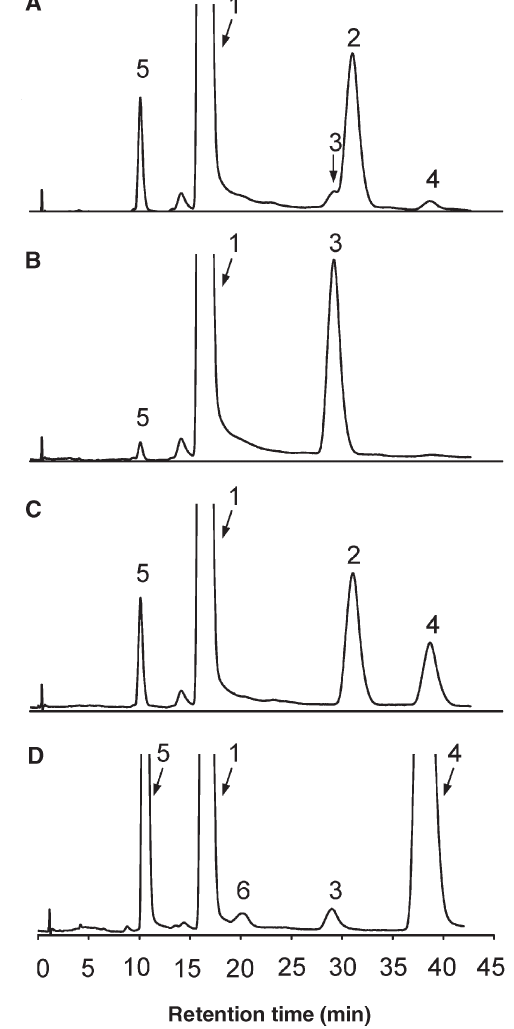
Figure 5. The HPLC analysis of reaction products. (A) Glycosynthase reaction of E170A LamA with α -laminaribiosyl fluoride (6) and Glc β 3Glc β -MU (1); (B) glycosynthase reaction of E134A (endo- β - 1,3-1,4-glucanase from B. licheniformis ) with α -laminaribiosyl fluo- ride (6) and G lc β 3 β Glc β -MU (1); (C) digestion of reaction mixture A with wild-type endo- β -1,3-1,4-glucanase from B. licheniformis ; (D) digestion of reaction mixture A with wild-type LamA. Peaks in the chromatogram were identified by coinjection with independed stan- dards. Peak labels: 1. Glc β 3Glc-MU (1) with retention time, t R = 17.2 min; 2. Glc β 3Glc β 3Glc β 3Glc-MU (10), t R = 31.1 min; 3. Glc β 3Glc β 4Glc β 3Glc-MU (9), t R = 29.5 min; 4. MU, t R = 38.8 min; 5. Glc β -MU (5), t R = 10.5 min; and 6. unidentified hydrolysis prod- uct, t R = 20.1